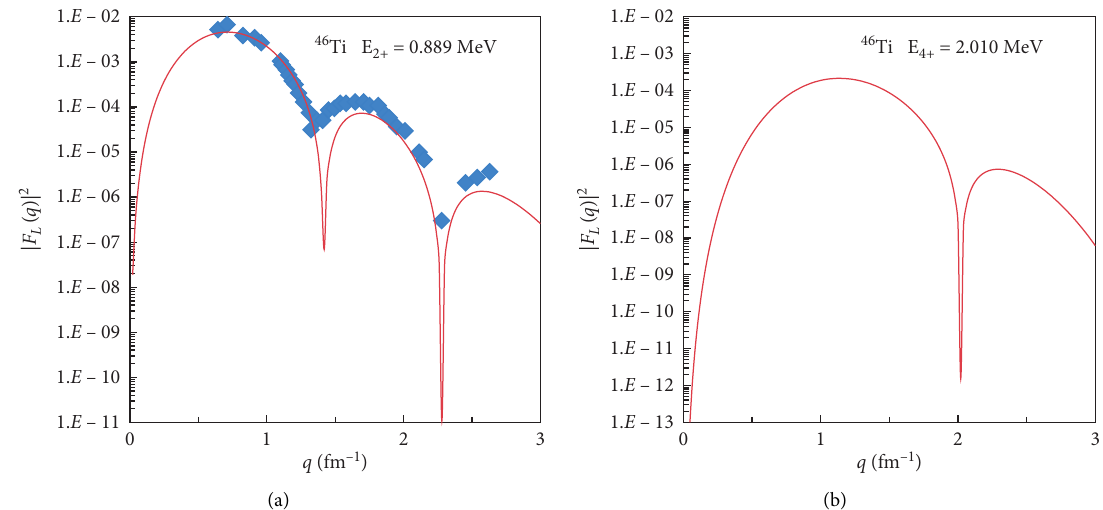
Figure 1: Inelastic longitudinal form factors of 46 Ti. (a) E(2 + ) transition, the practical data are taken from reference [4]. (b) E(4 + ) transition.